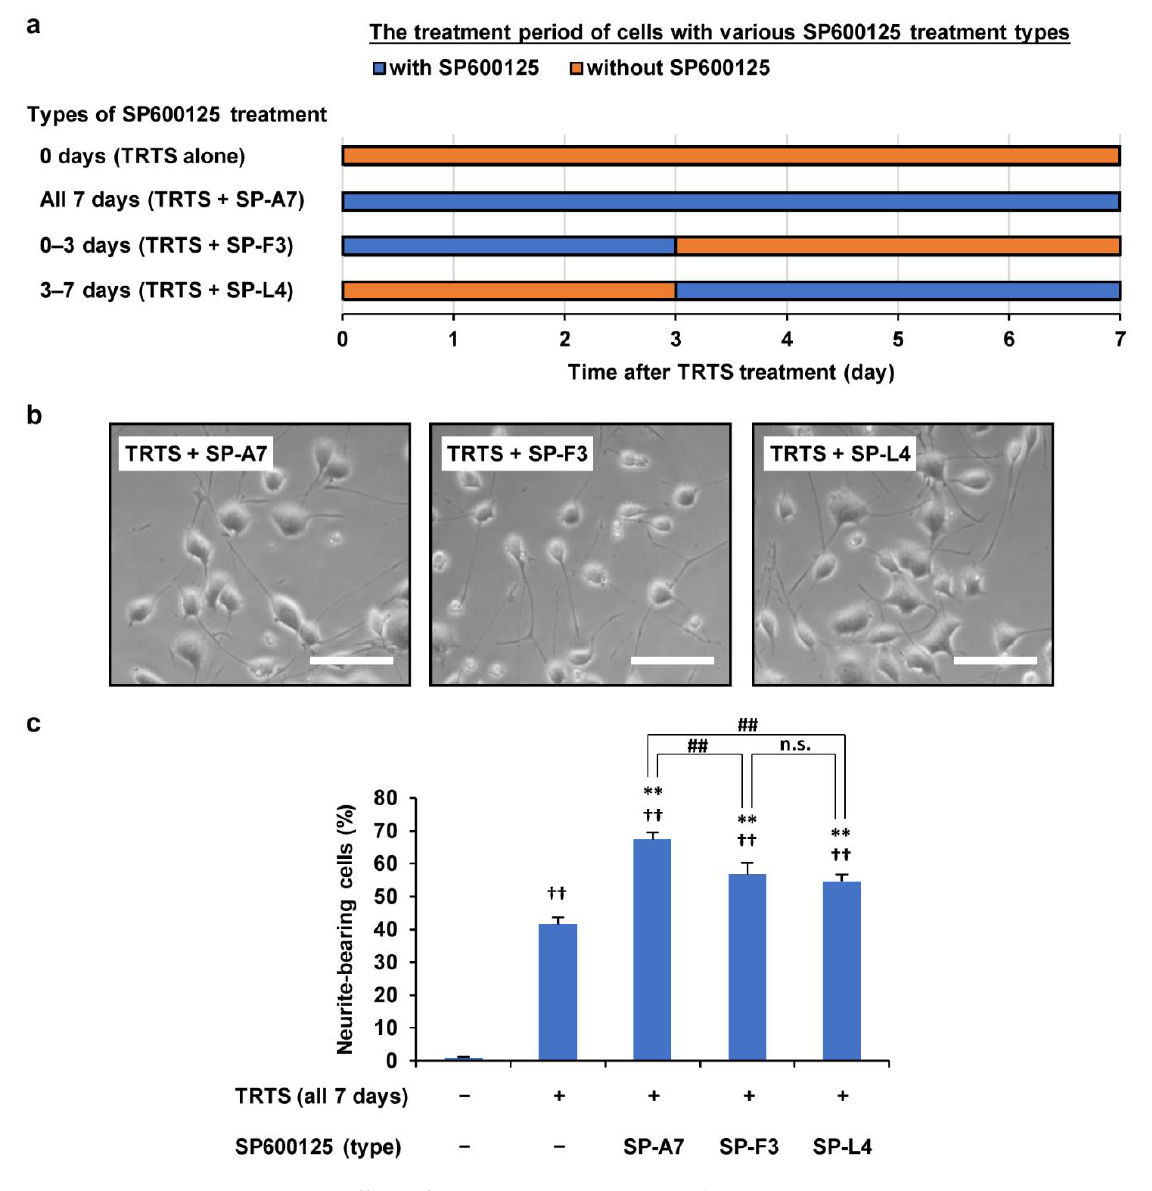
Figure 5. Effects of various treatment times with 0.5 µ M SP600125 on PC12-P1F1 neuritogenesis while undergoing TRTS exposure. ( a ) Schematic representation of the treatment times of PC12-P1F1 cells with SP600125 in the presence of TRTS. PC12-P1F1 cells were stimulated with SP600125 under TRTS exposure as follows: all 7 days (TRTS + SP-A7), first 3 days (TRTS + SP-F3), and last 4 days (TRTS + SP-L4). ( b ) Phase-contrast images of PC12-P1F1 cells on day 7. Scale bars: 100 µ m. ( c ) Percentage of neurite-bearing cells on day 7. Cells that did not undergo TRTS or SP600125 treatment were defined as the negative control group. The data represent the means ± standard deviation of three